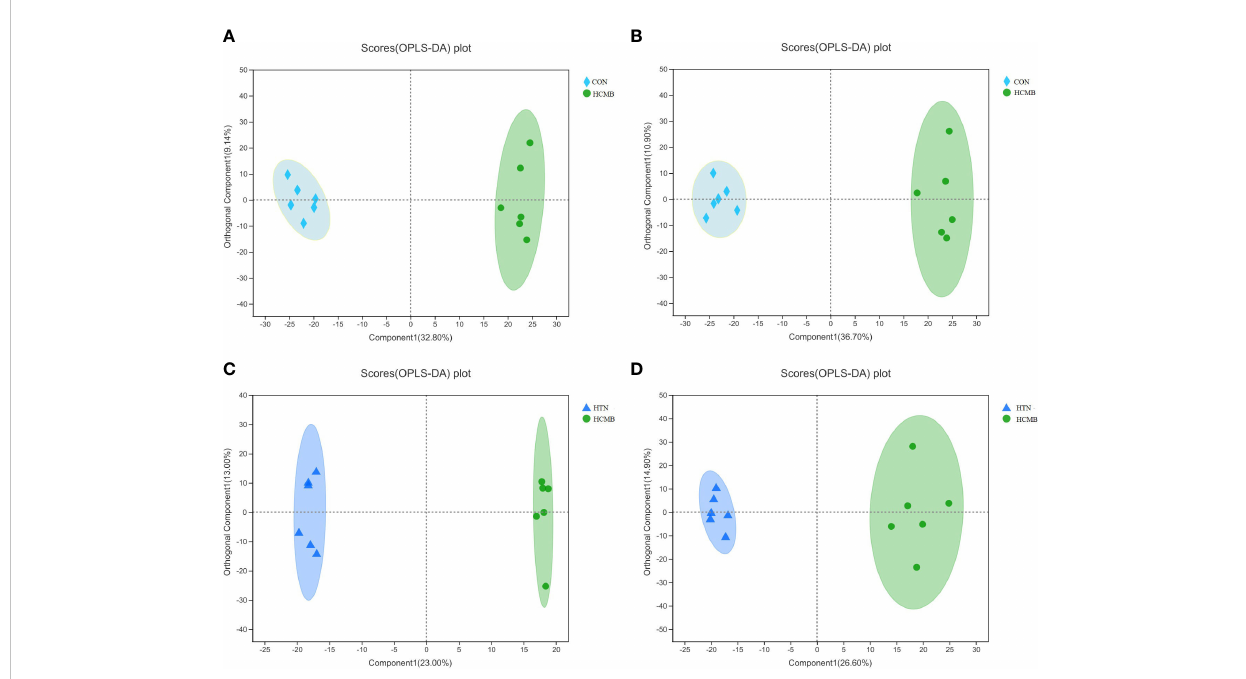
FIGURE 5 OPLS-DA score plot. (A) : HCMB vs CON cation table scatter plot. (B) : HCMB vs CON anion table scatter plot. (C) : HCMB vs HTN cation table scatter plot. (D) : HCMB vs HTN anion scatter plot. Comp1 fi rst predicted principal component explanatory degree, orthogonal Comp1 fi rst orthogonal component explanatory degree. The greater the separation of the two groups of samples in the graph, the more signi fi cant the classi fi cation effect. OPLS-DA, orthogonal least partial square discriminant analysis; CON, control group; HTN, hypertension; HCMB, hypertensive cerebral